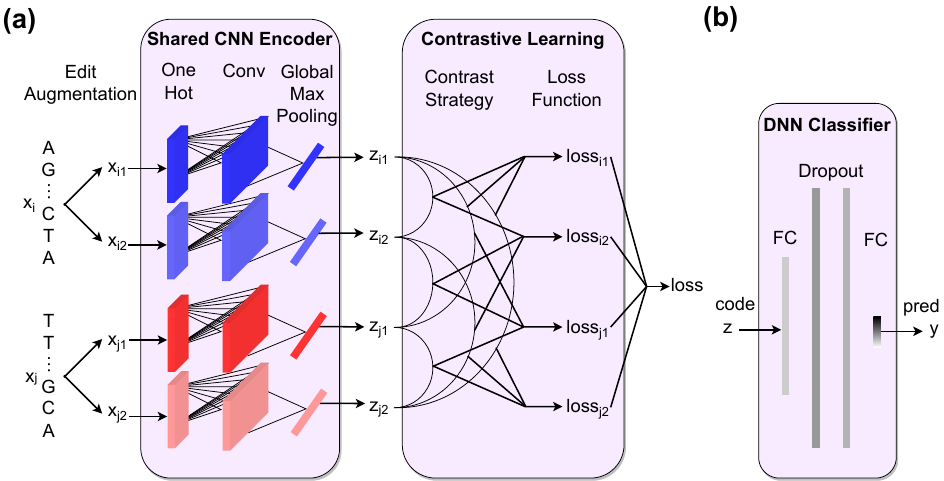
Figure 1. An overview of our ( a ) CNN encoder and contrastive learning procedure and ( b ) DNN classifier. Sequences ’AG...CTA’ and ’TT...GCA’ are examples of a mini-batch input raw DNA sequences. Conv denotes a convolution layer. FC denotes a full connection layer. The mark ’code’ represents encoded features and ’pred’ represents output prediction